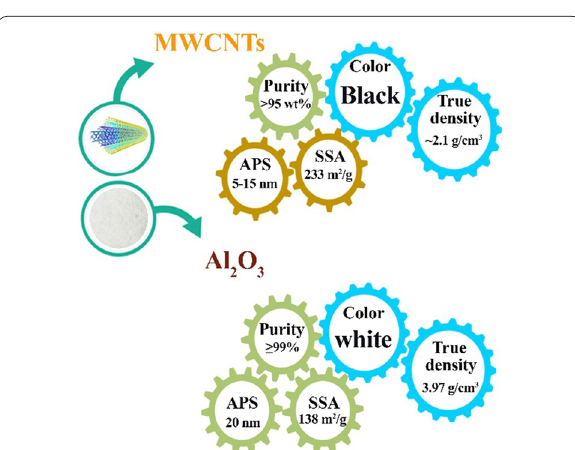
Fig. 3 Physical and surface characteristics of applied nanoparticles